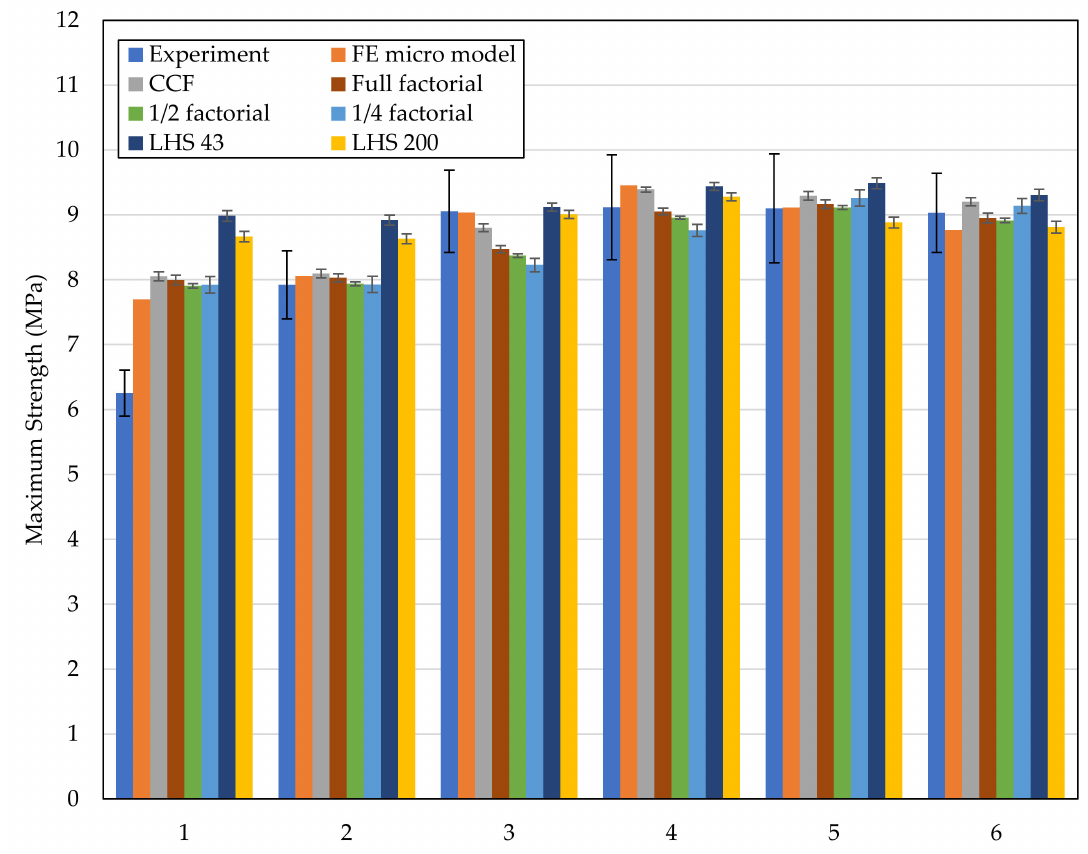
Figure 7. Validation of the approach by comparing the prediction of the strength of the surrogate models, FE micro model, and